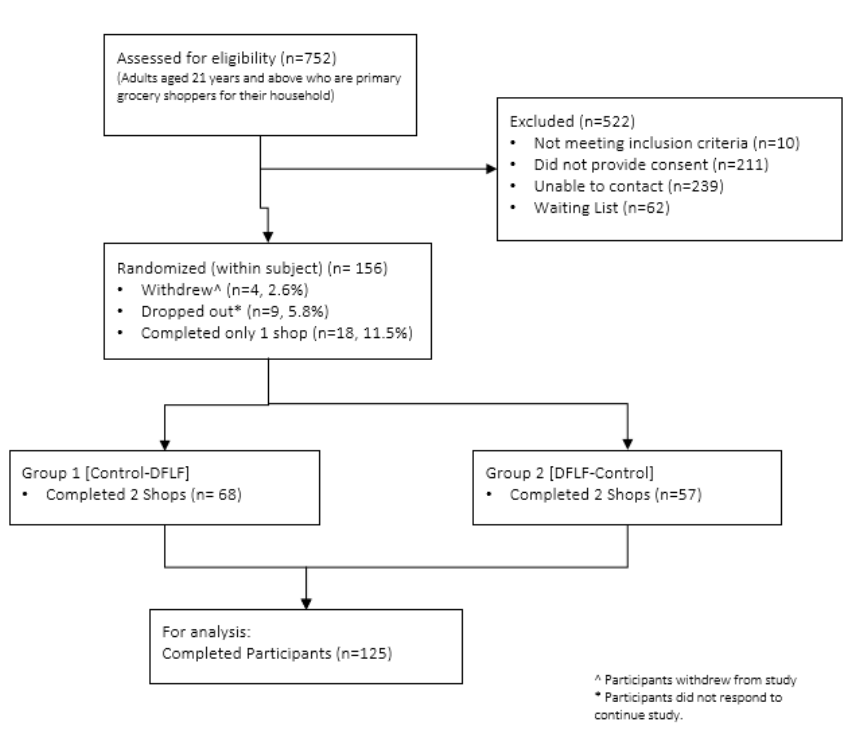
Figure 4. CONSORT flow diagram for participation recruitment and randomization.